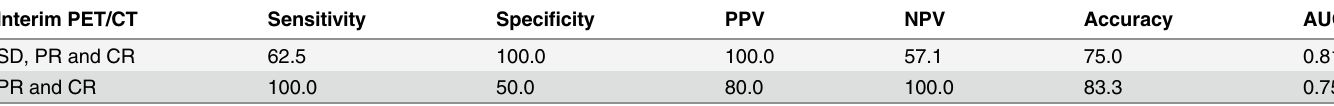
Table 4. Result based on EORTC for predicting progression free survival at 12 months (n = 12). Interim